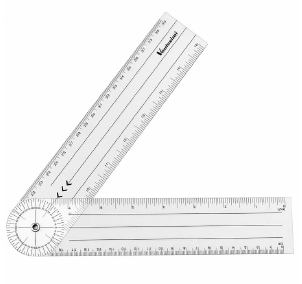
Figure 5. Dual-arm universal goniometer.